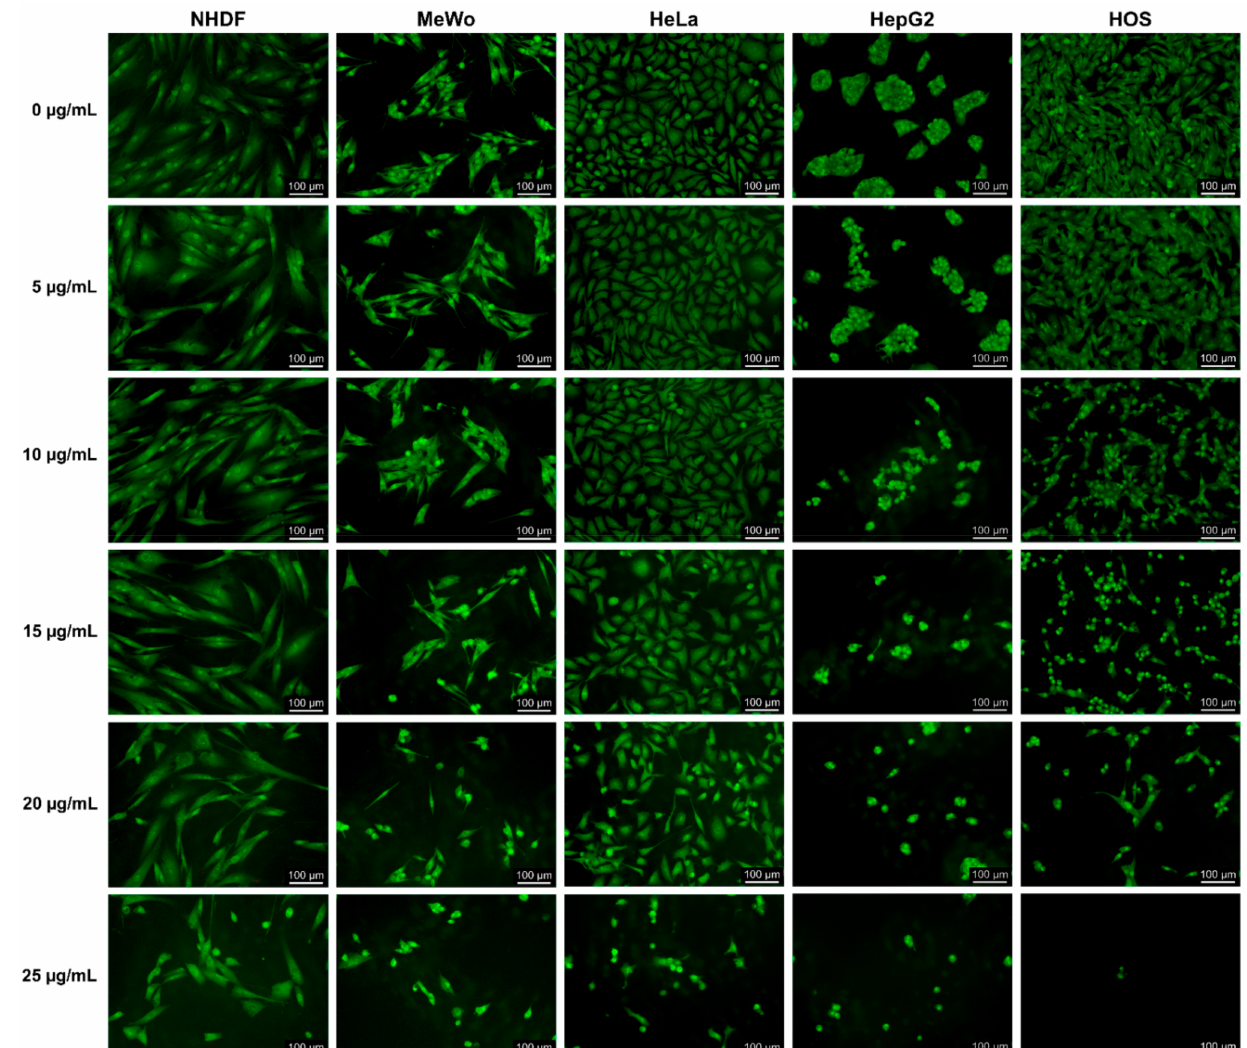
Figure 8. AO/EB staining of normal dermal fibroblasts (NHDF), malignant melanoma (MeWo), adenocarcinoma (HeLa), hepatocellular carcinoma (HepG2) and osteosarcoma (HOS) cells treated with CBD-enriched hemp oil at 5, 10, 15, 20 and 25 µ g CBD/mL for 48 h. Control cells were incubated with complete cell culture medium (represented as 0 µ g